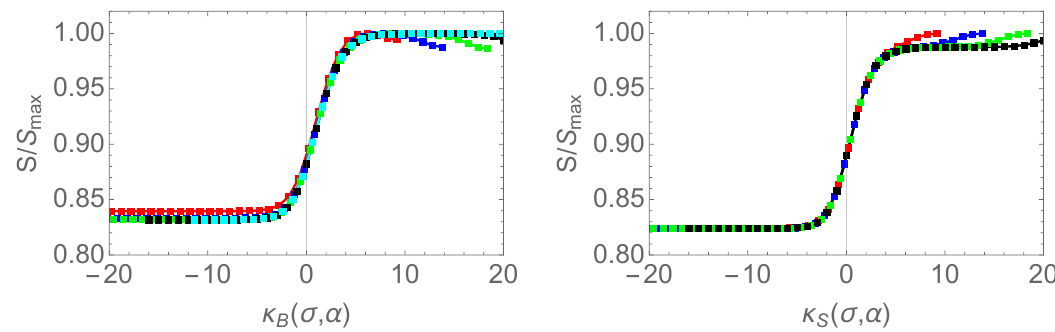
Figure 6 . The entropy normalised by its maximum value against the scale κ i p α, σ q defined in (5.3) for fixed α “ 10 ´ k and k “ 2 , 3 , 4 , 5 , 6 and varying σ for K observe the collapse of curves, with the midpoint of the kink, located at κ threshold for the formation of the unstable particle. In both panels the lower plateau is at around 5 { 6 “ 0 . 8333 . . . which is the ratio of CFT central